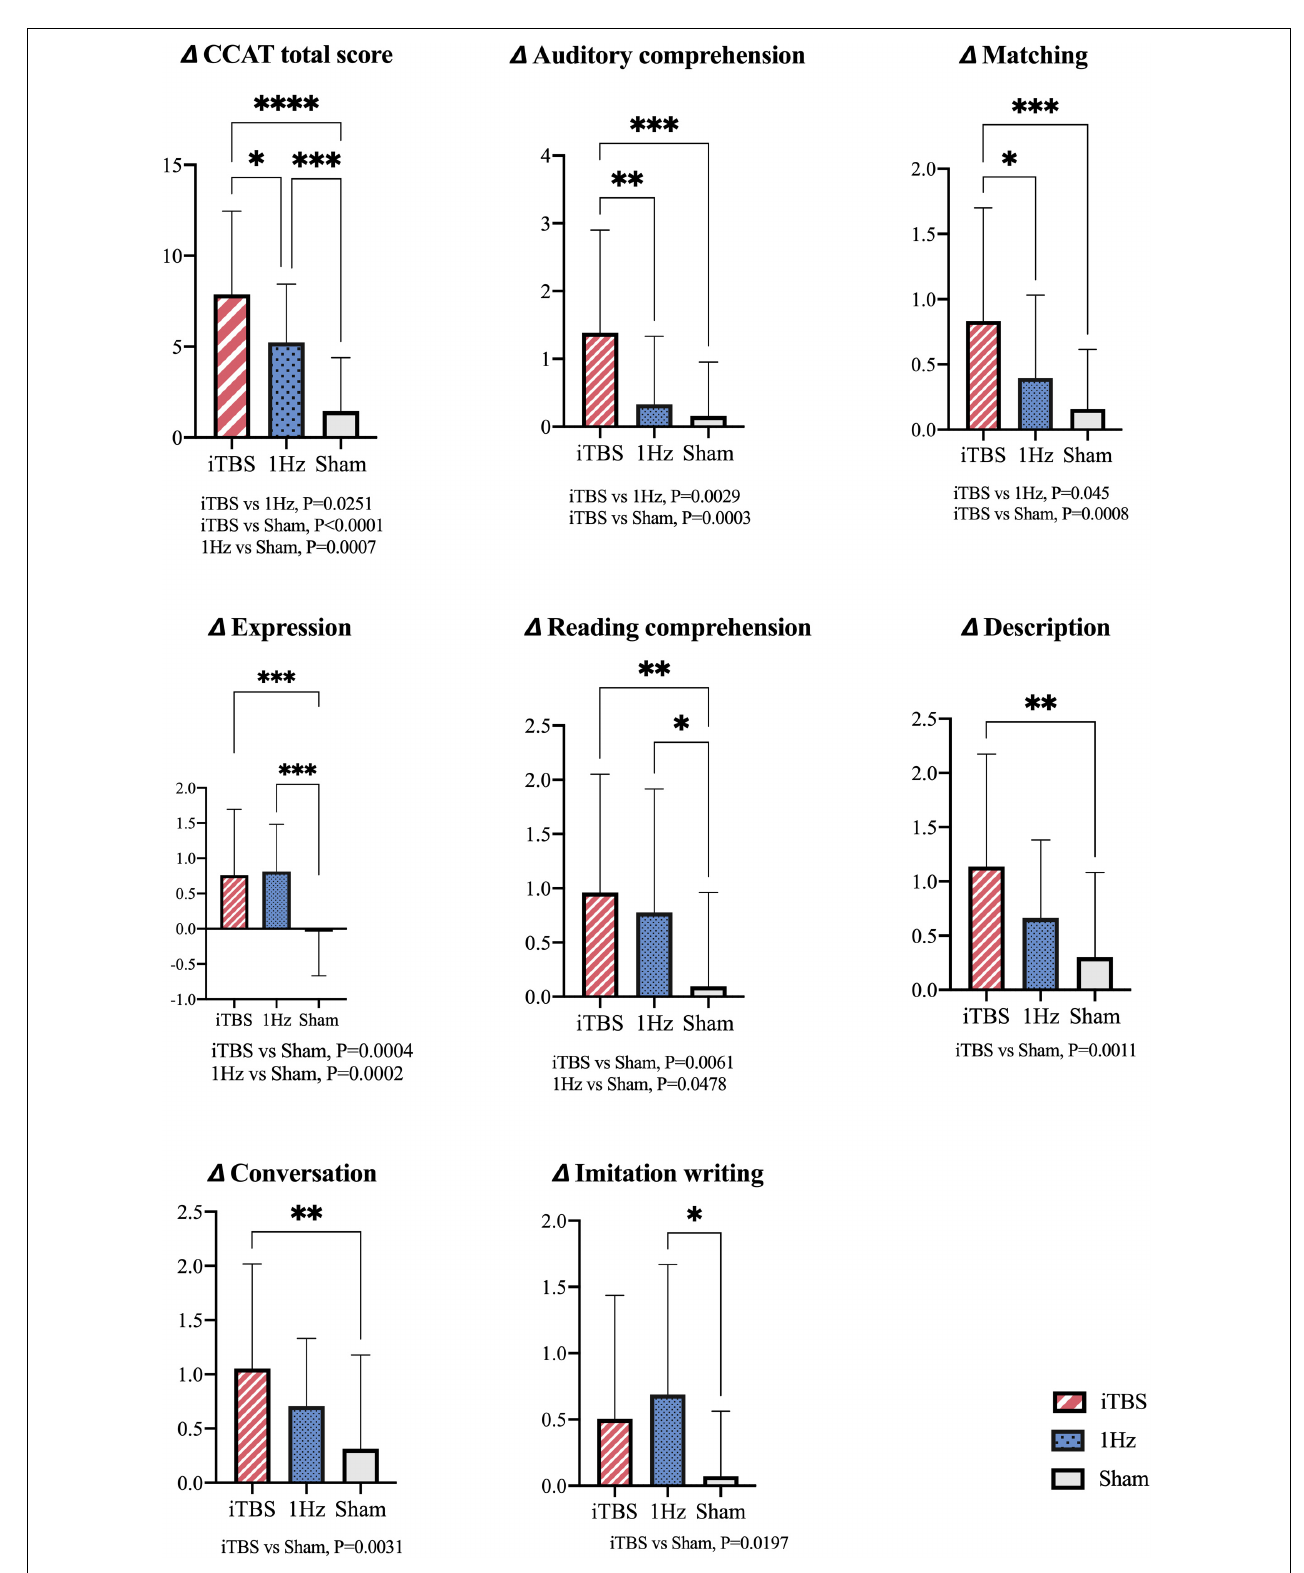
FIGURE 2 | Intergroup comparisons for changes of total CCAT scores and subtest scores. *Indicates significant difference between groups at P < 0.05; ∗∗ P < 0.01; ∗∗∗ P < 0.001; ∗∗∗∗ P < 0.0001. ANOVA; Post hoc analysis: Bonferroni correction.